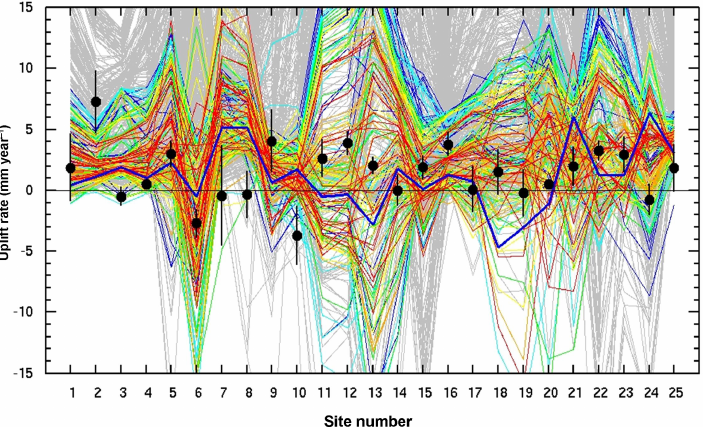
Figure D3. Model vs. observed modern uplift rates, for the 25 sites in the compilation (Whitehouse et al., 2012b) that lie within the model’s West Antarctic domain, shown roughly in west-to-east order. The observations and uncertainty ranges are shown as black dots and whiskers. Model rates are shown for all 625 runs, with straight lines joining the sites, and aggregate scores S indicated by colors as in Fig. 5. The run with best aggregate score S is shown as a thick blue line. Sites shown, with labels as in Whitehouse et al. (2012b, Supplement), are: 1. FTP1,